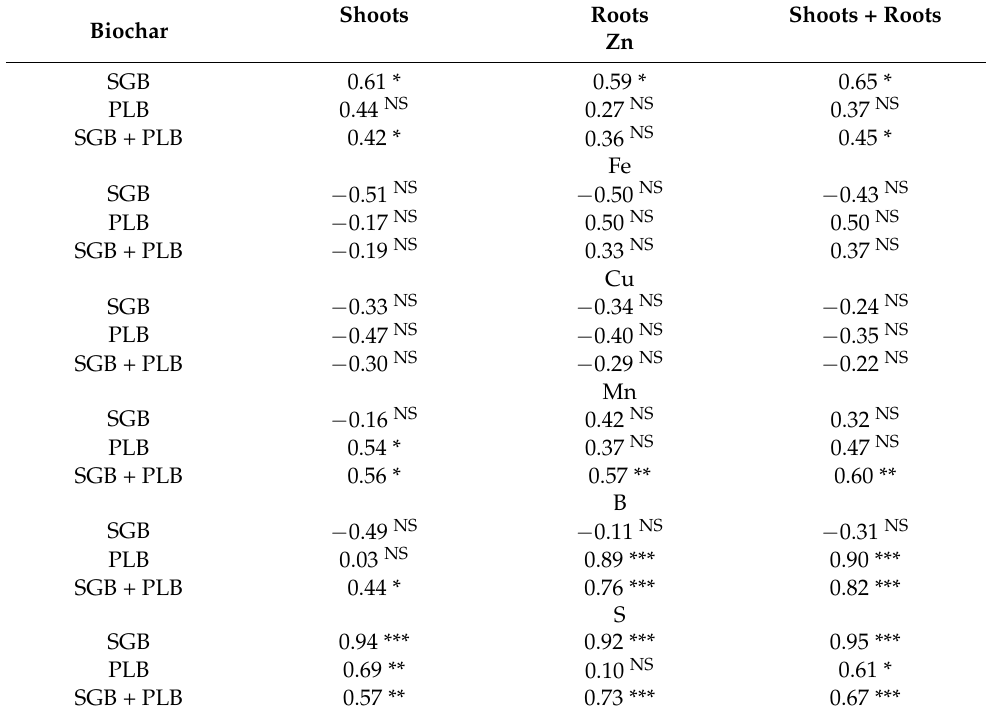
(Table 4), which support the use of the M-3 solution as an extractant for plant-available S in soils amended with biochars under similar conditions to those studied. Table 5. Pearson correlations between Mehlich-3-extractable Zn, Fe, Cu, Mn, B, and S and those nutrient concentrations in ryegrass shoots and